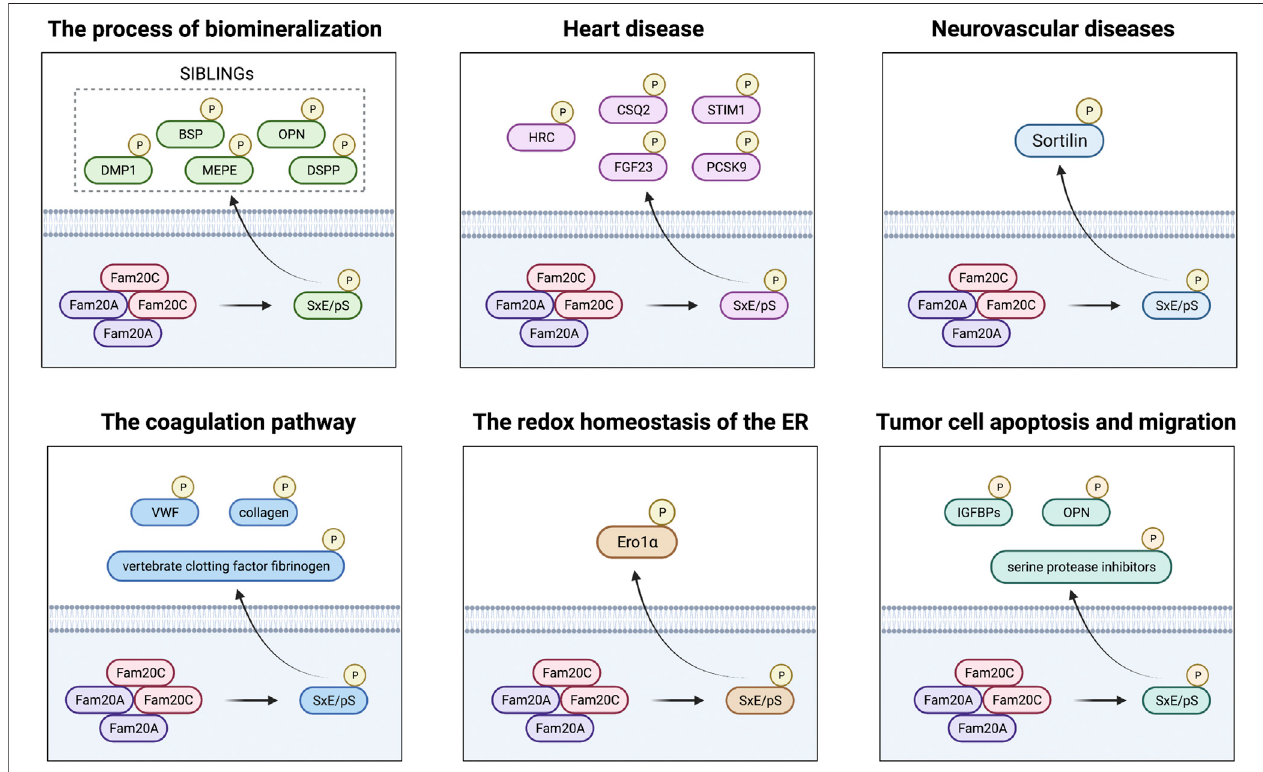
FIGURE 1 | FAM20C plays a role in biomineralization, heart disease, neurovascular disease, blood coagulation, the redox homeostasis of the ER, and tumor disease through different substrates.